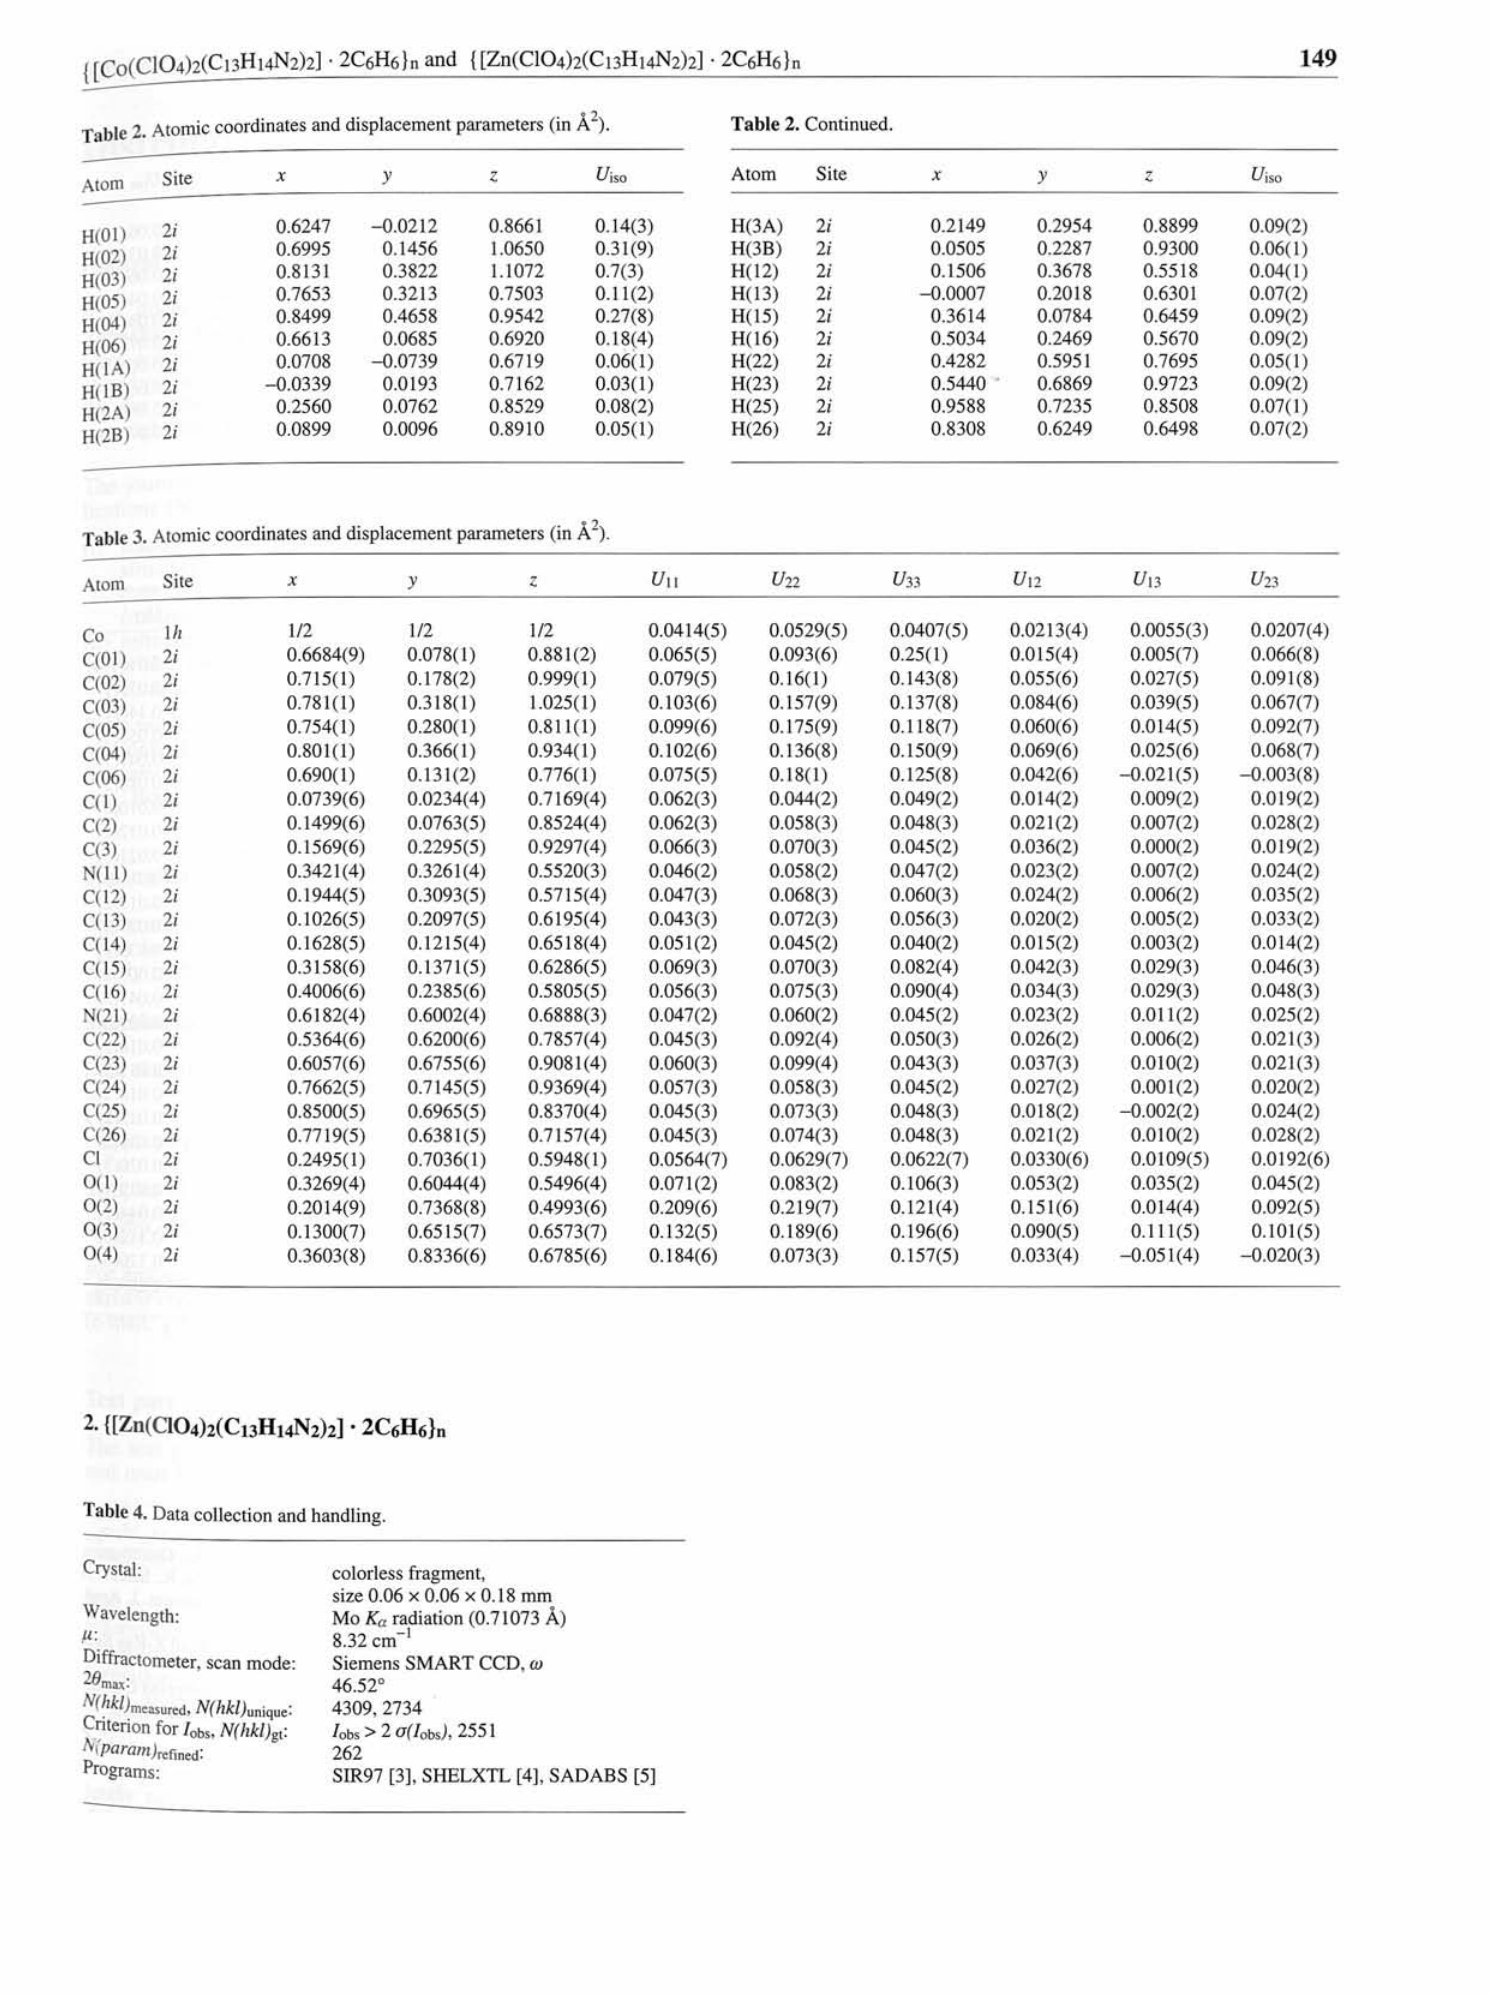
Table 4. Data collection and